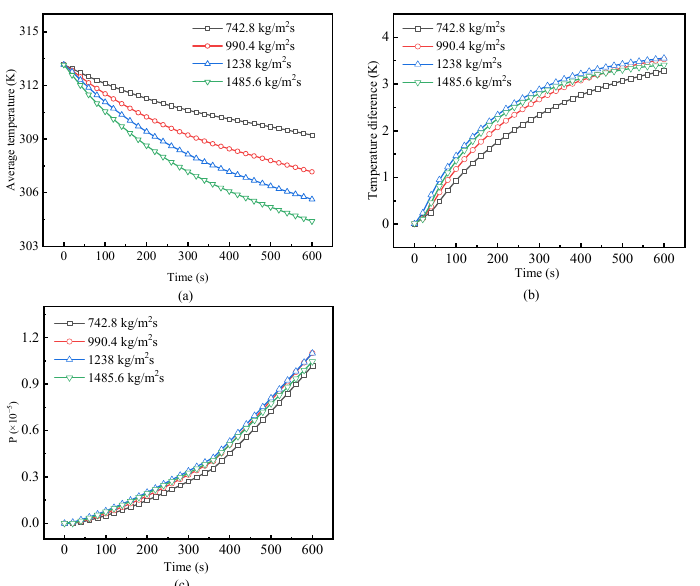
Figure 8. The effects of mass flux. ( a ) Average temperature of the module; ( b ) Temperature uniformity of the module; ( c ) Battery consistency in the module.